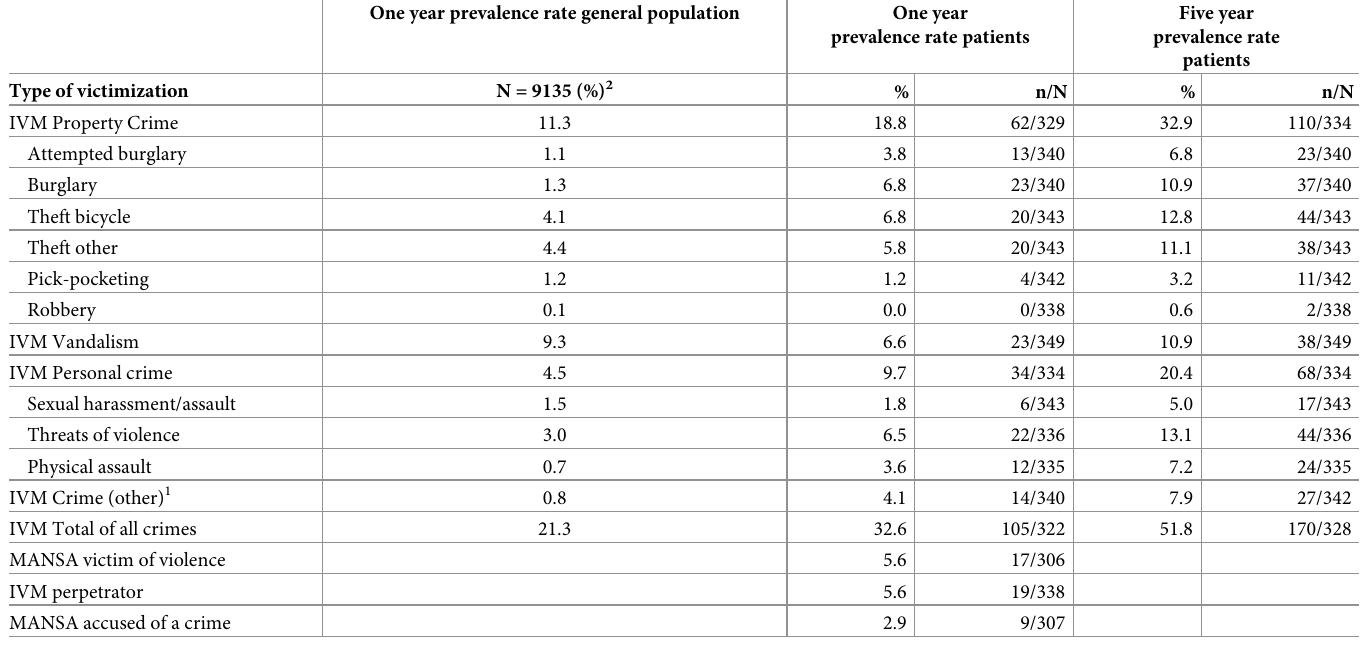
Table 1. Victimization prevalence rate for the general population and for patients with a psychotic disorder.